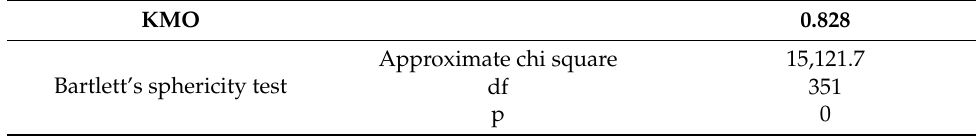
Table A1. KMO and Bartlett’s sphericity test.